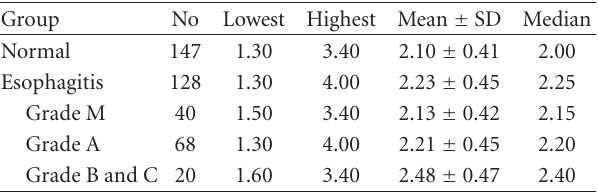
Table 3: FDG uptake (SUVmax) in normal subjects and subjects with gastroesophageal reflux esophagitis in FDG-PET.